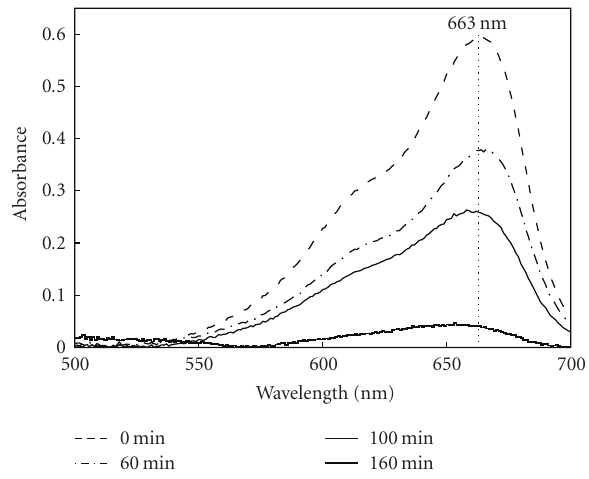
Figure 2: UV-vis absorption spectra of MB solution catalyzed by the TiO 2